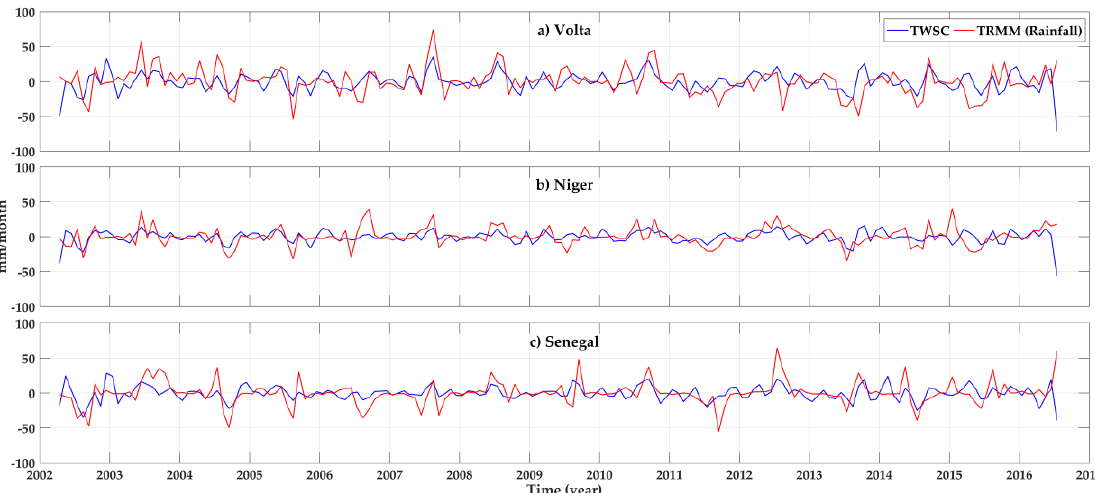
Figure 9. Time series of rainfall anomalies (after removing the mean seasonal cycle) for the total water storage change (TWSC) (blue solid line) and Tropical Rainfall Measurement Mission (TRMM) (red solid line) anomalies of the Volta Basin ( a ), Senegal Basin ( b ), and Niger Basin ( c ) Basins in mm/month. The three datasets overlap from 2002 to 2013.